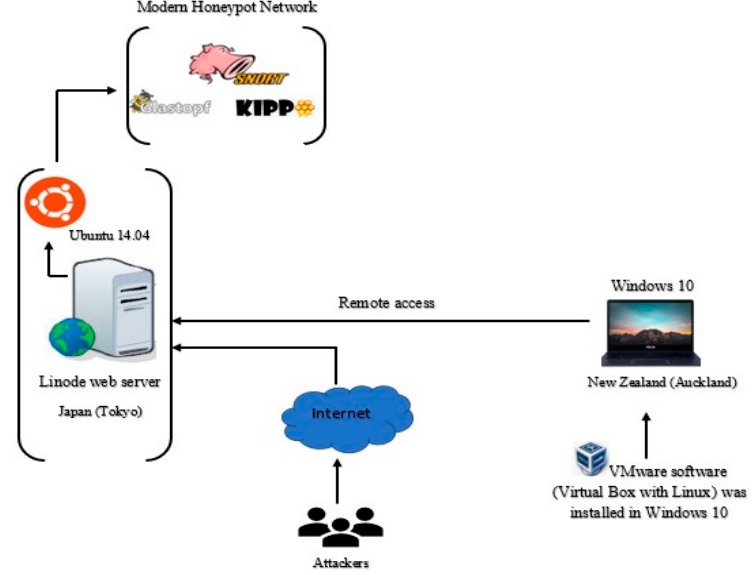
Figure 3. The steps of the honeypot deployment network for experimentation.